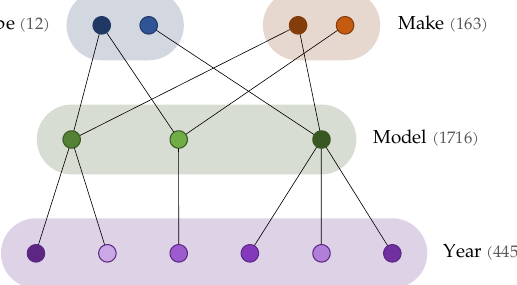
Figure 1. Hierarchy of labels in the CompCars dataset, comprised of a total of 136,725 images. The reported numbers identify the cardinality of the classes at each specific level.